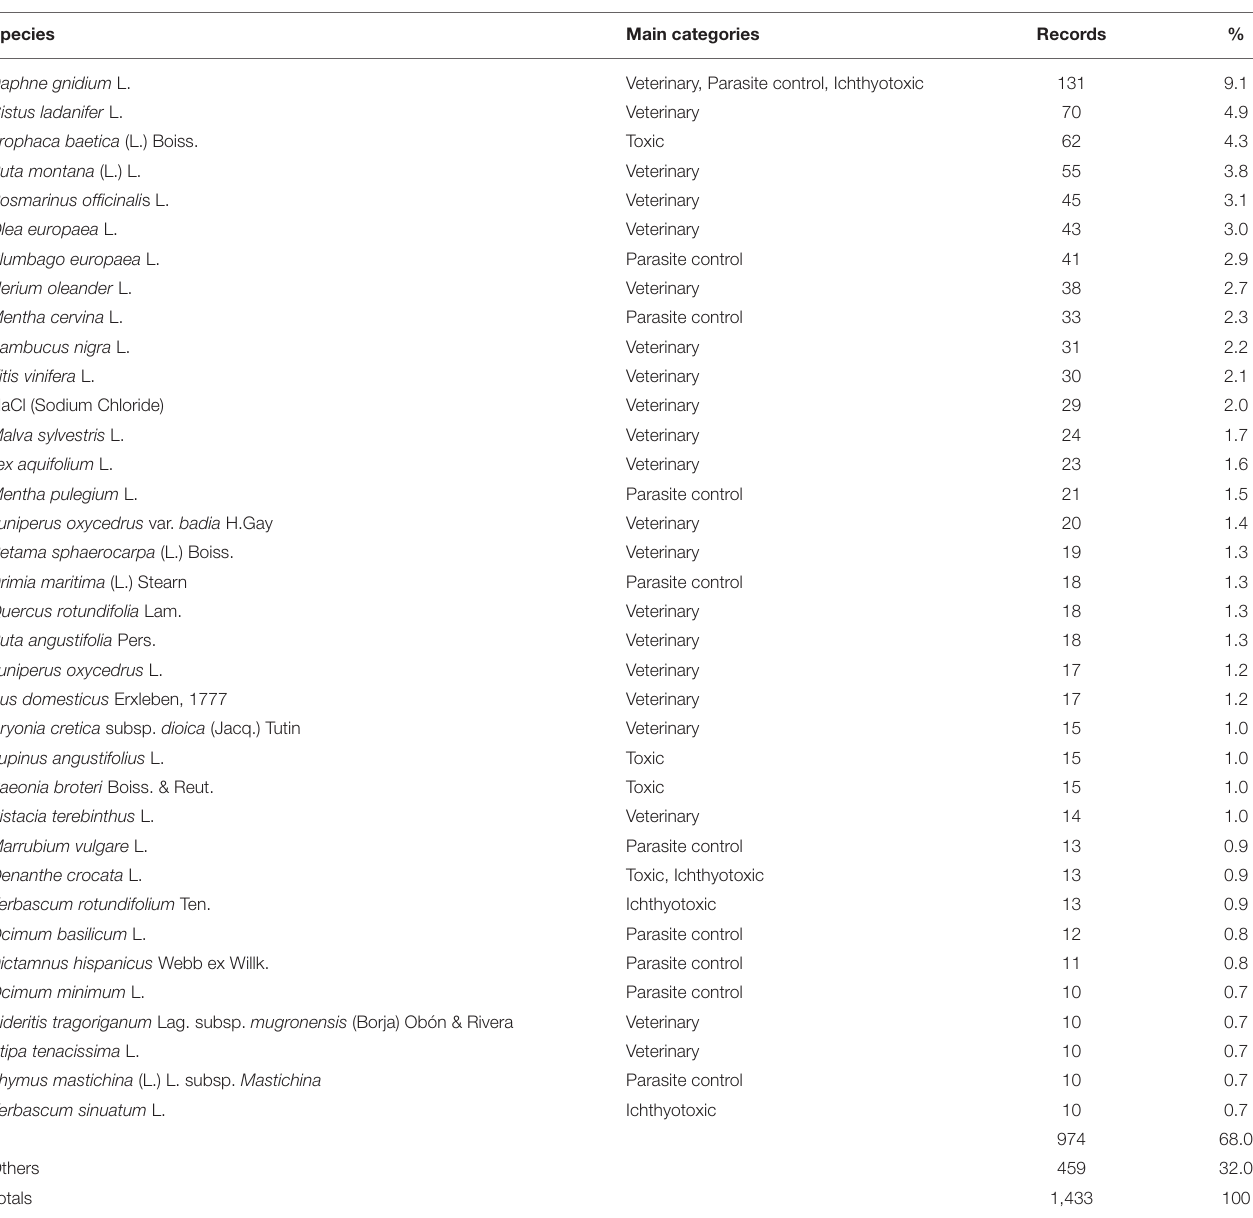
TABLE 3 | Most frequent species in the veterinary of transhumance in Castile La-Mancha.